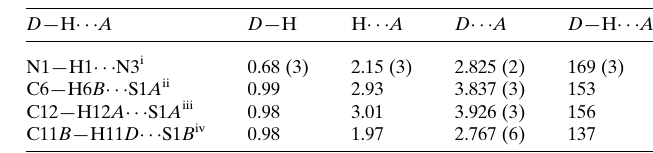
Table 1 Hydrogen-bond geometry (A˚ , (cid:2)